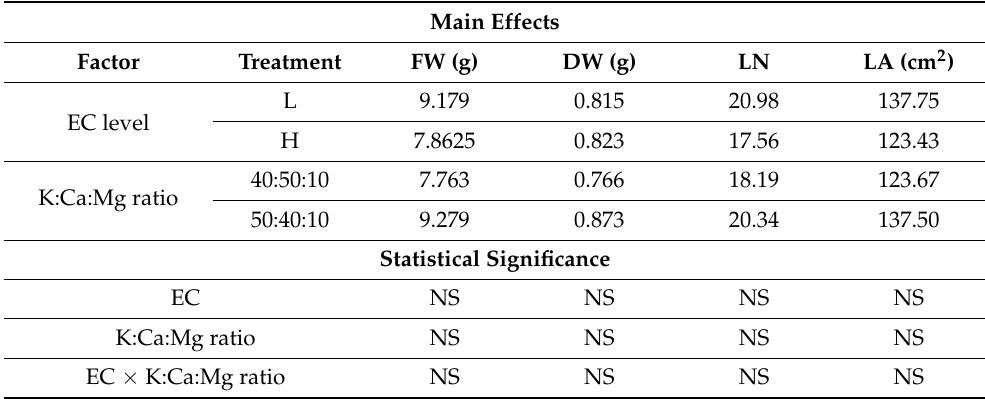
Table 2. Impact of different EC levels (low and high, as L and H, respectively) and K:Ca:Mg ratios (40:50:10 and 50:40:10) on the fresh weight (FW), dry weight (DW), leaf number (LN) and leaf area (LA) of spiny chicory cultivated in a hydroponic floating raft system.